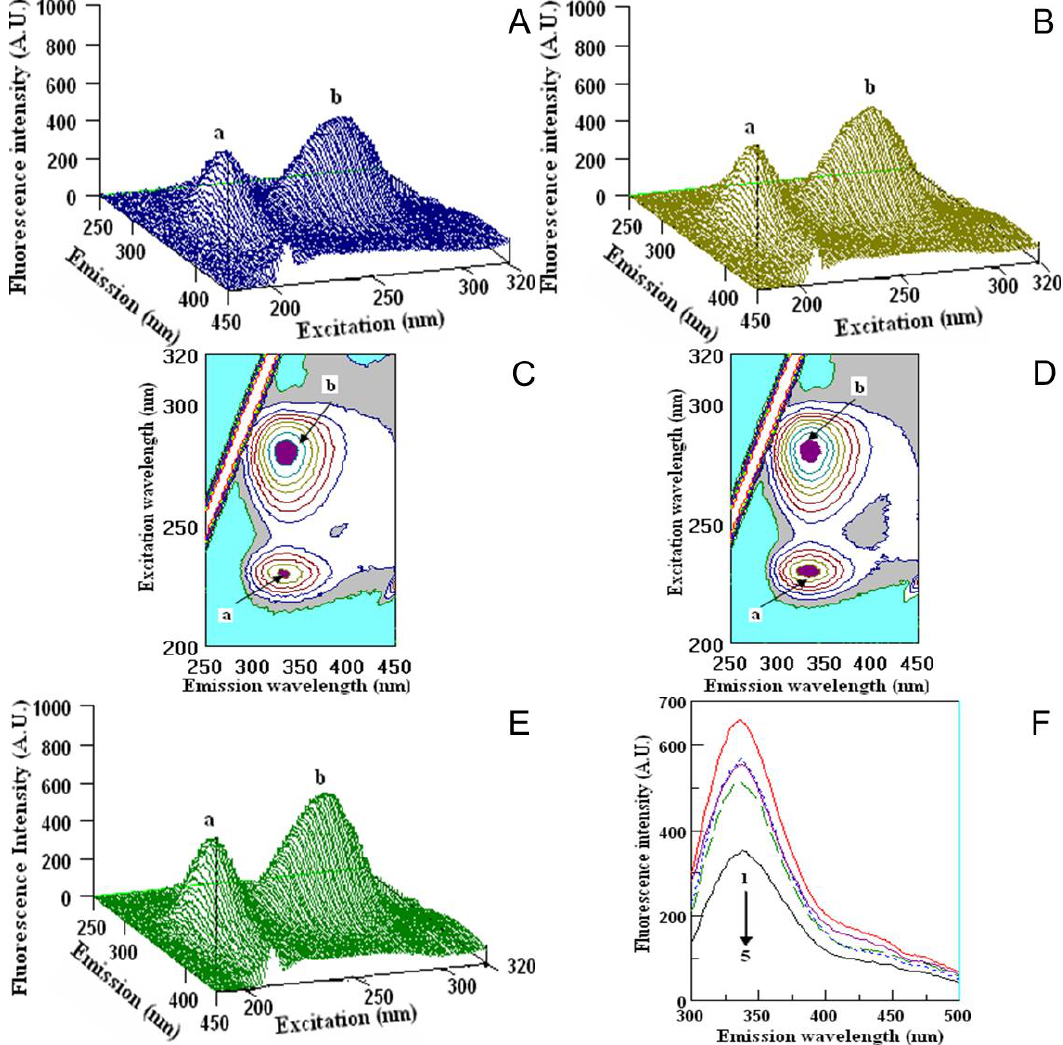
Figure 9. Fluorometric measurements in three-dimensional fluorescence analysis (3D-FL) of kiwifruit and persimmon extracts after interaction with globulin. ( A , B ) 3D-FL of KH and PF after interaction with α - β G, and ( C , D ) their cross images. ( E ) α - β G; ( F ) spectral data of two-dimensional fluorescence measurements (2D-FL) of fruit extracts and α - β G from the top: 1, 2, 3, 4, 5, α - β G (FI = 658.57.71 A.U.), α - β G + PF (FI = 567.49 A.U.); α - β G + quercetin (FI = 554.04 A.U.); α - β G + KH (FI = 515.68 A.U.), α - β G + tannic acid (FI = 353.19 A.U.). Abbreviations: KH, Actinidia (A.) deliciosa cv. Hayward; PF, Diospyros kaki Thunb. cv. Fuyu; α - β G, α - β -globulin; FI, fluorescence intensity; A.U, arbitral units. The locations of peaks a and b are shown in Figures 7 and 9 (for interpretation of the references to color in this figure legend, the reader is referred to the web version of this article).